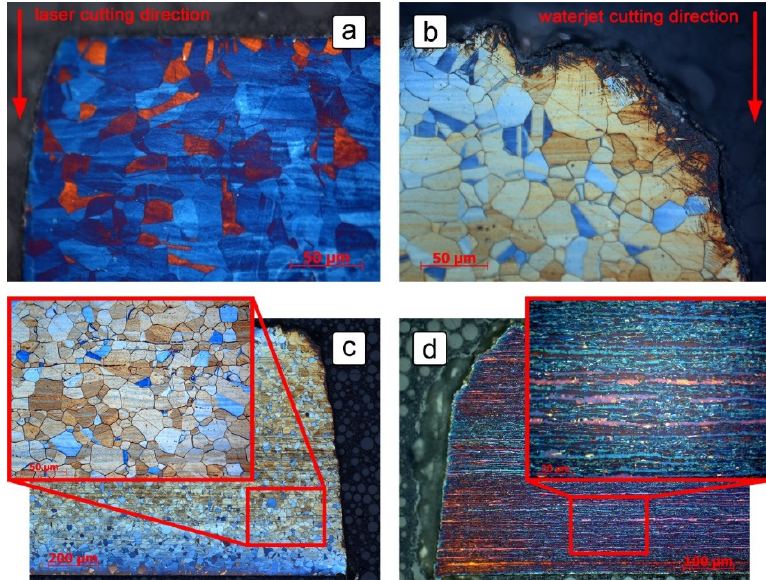
Figure 4. Metallographic images of: ( a ) the angular shape of the laser cut edge in the grade 316L steel sheet; ( b ) strain-induced deformation martensite formed on the edges of the steel sheet cut by abrasive waterjet technique; ( c ) the austenitic microstructure of steel grade 316L with longitudinally oriented inclusions and phases; ( d ) the microstructure of steel grade 2507 with elongated crystal grains in the rolling direction of the